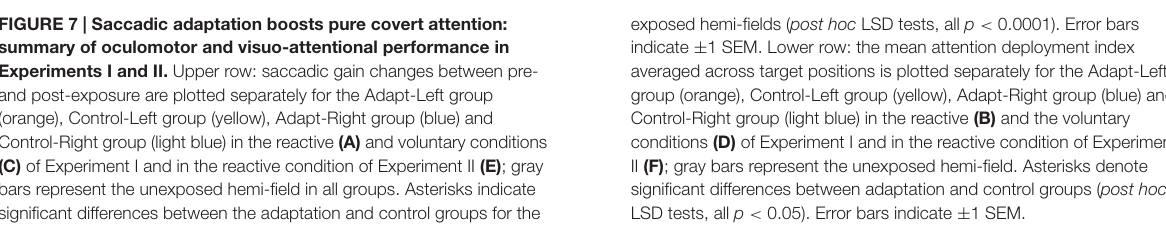
FIGURE 7 | Saccadic adaptation boosts pure covert attention: summary of oculomotor and visuo-attentional performance in Experiments I and II. Upper row: saccadic gain changes between pre- and post-exposure are plotted separately for the Adapt-Left group (orange), Control-Left group (yellow), Adapt-Right group (blue) and Control-Right group (light blue) in the reactive (A) and voluntary conditions (C) of Experiment I and in the reactive condition of Experiment II (E) ; gray bars represent the unexposed hemi-field in all groups. Asterisks indicate significant differences between the adaptation and control groups for the